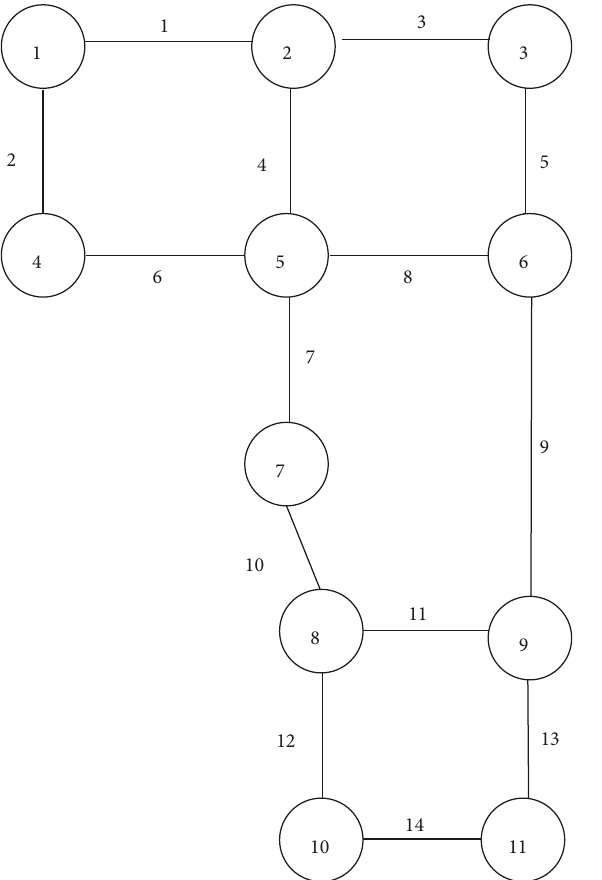
Figure 1: Simple road